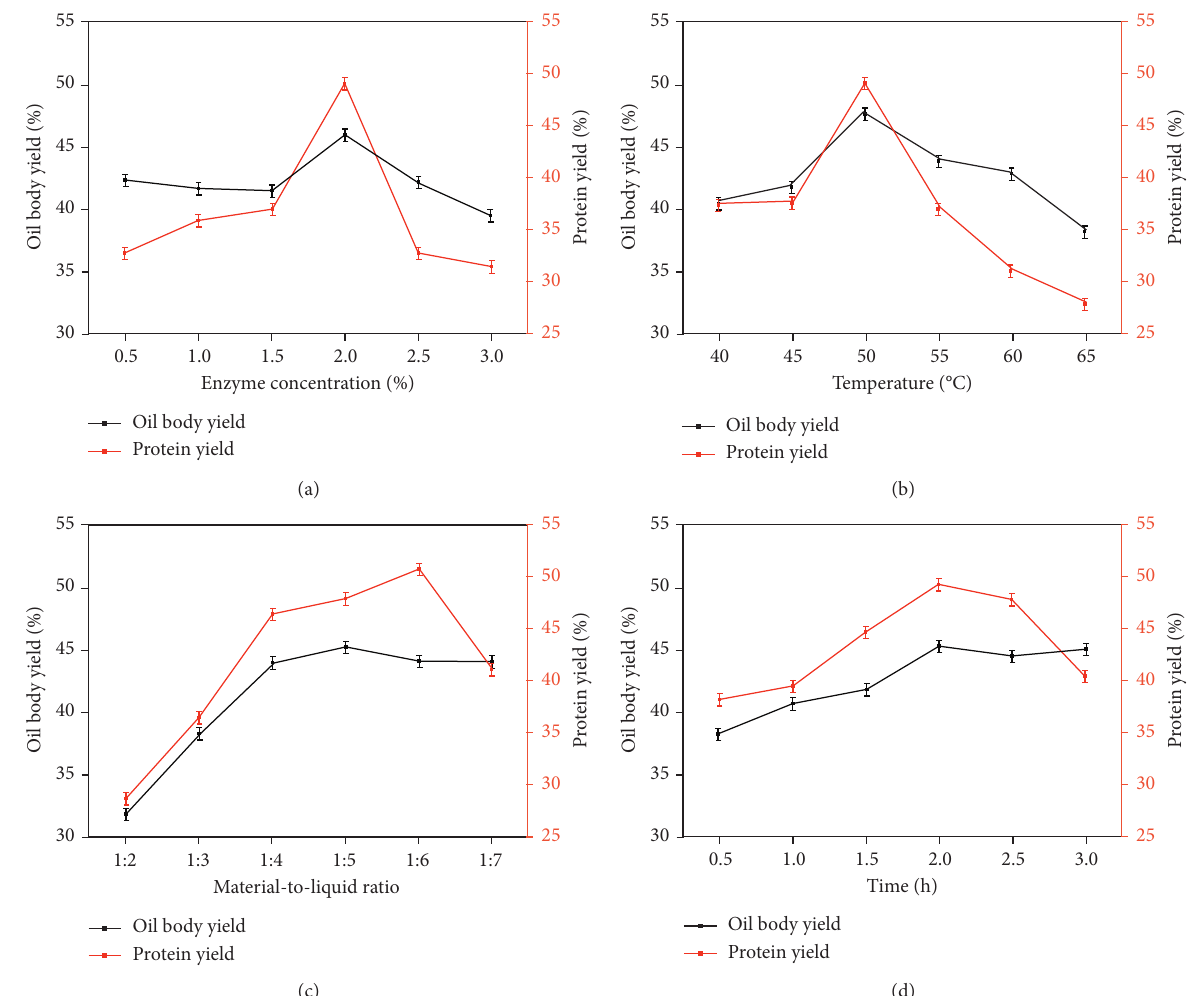
Figure 2: Effects of different parameters on the yields of oil body and protein extracted by cellulase: (a) enzyme concentration, (b) temperature, (c) material-to-liquid ratio, and (d) time.